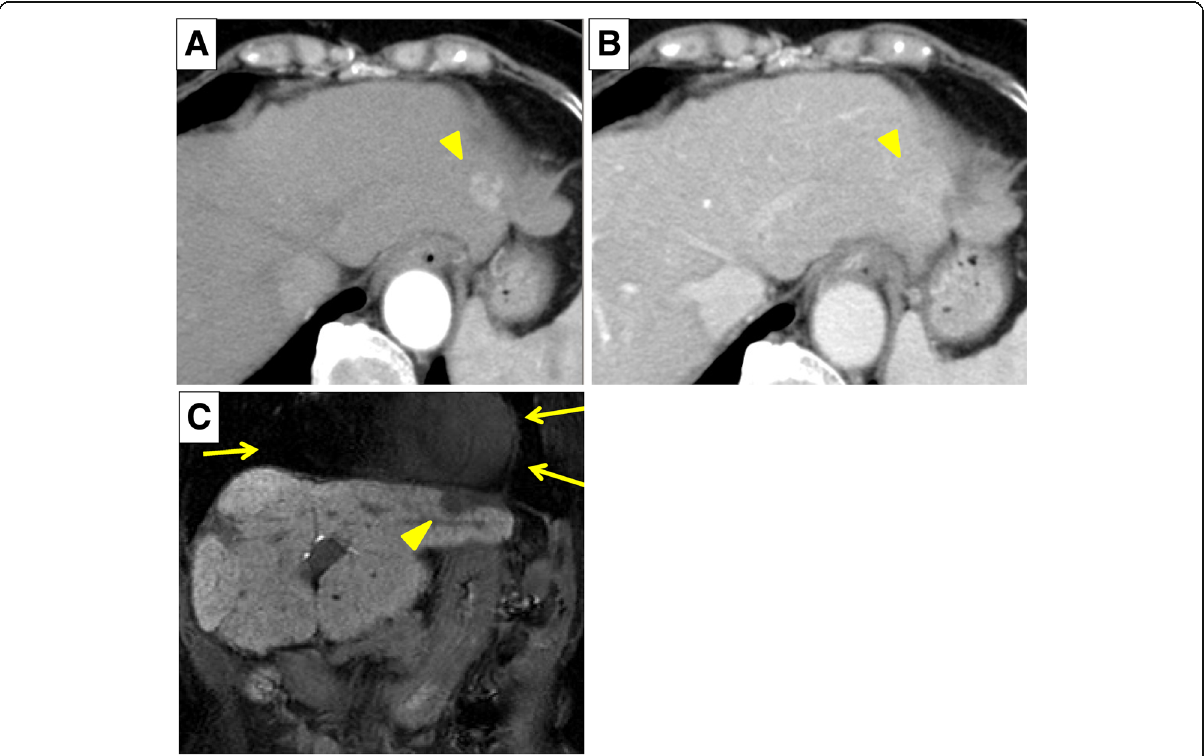
Fig. 1 Abdominal enhanced computed tomography prior to laparoscopic RFA. There was a 1.5-cm mass in the left lateral lobe of the liver (arrow head). a arterial phase, b portal phase, and c ethoxybenzyl diethylenetriamine-enhanced magnetic resonance imaging prior to laparoscopic RFA. The tumor (arrow head) was located just below the heart